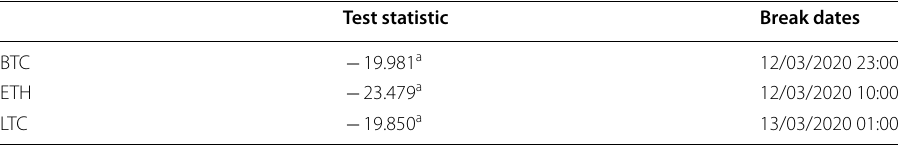
Table 6 Break point unit root test